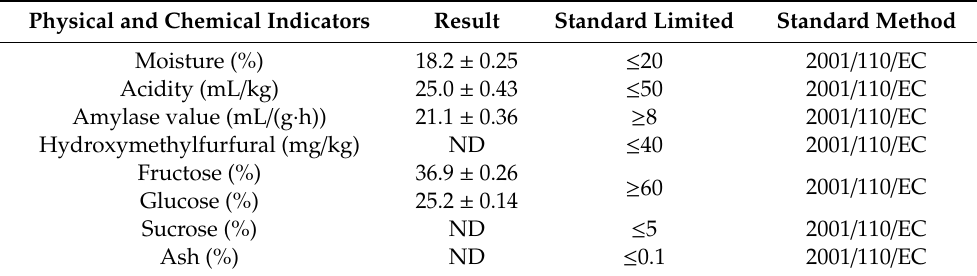
Table 3. The physical and chemical indicators of sa ffl ower